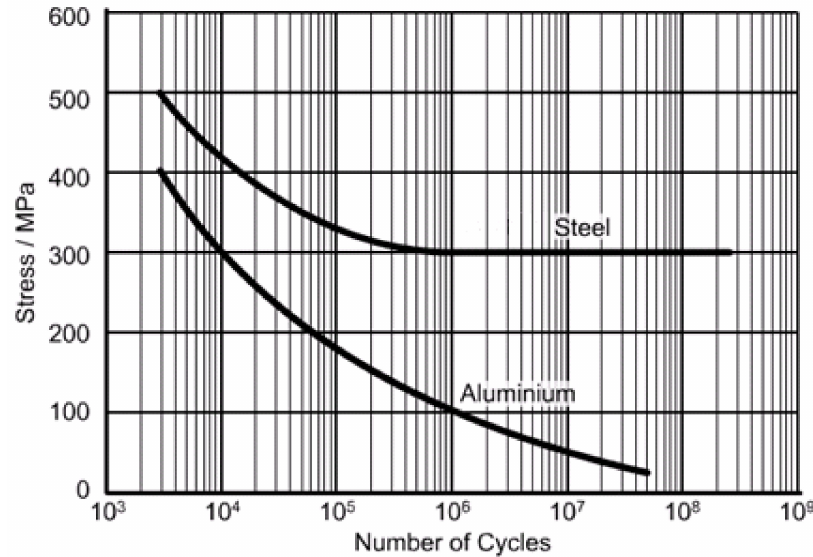
Figure 2. Aluminium and steel typical block loading sequence [21].